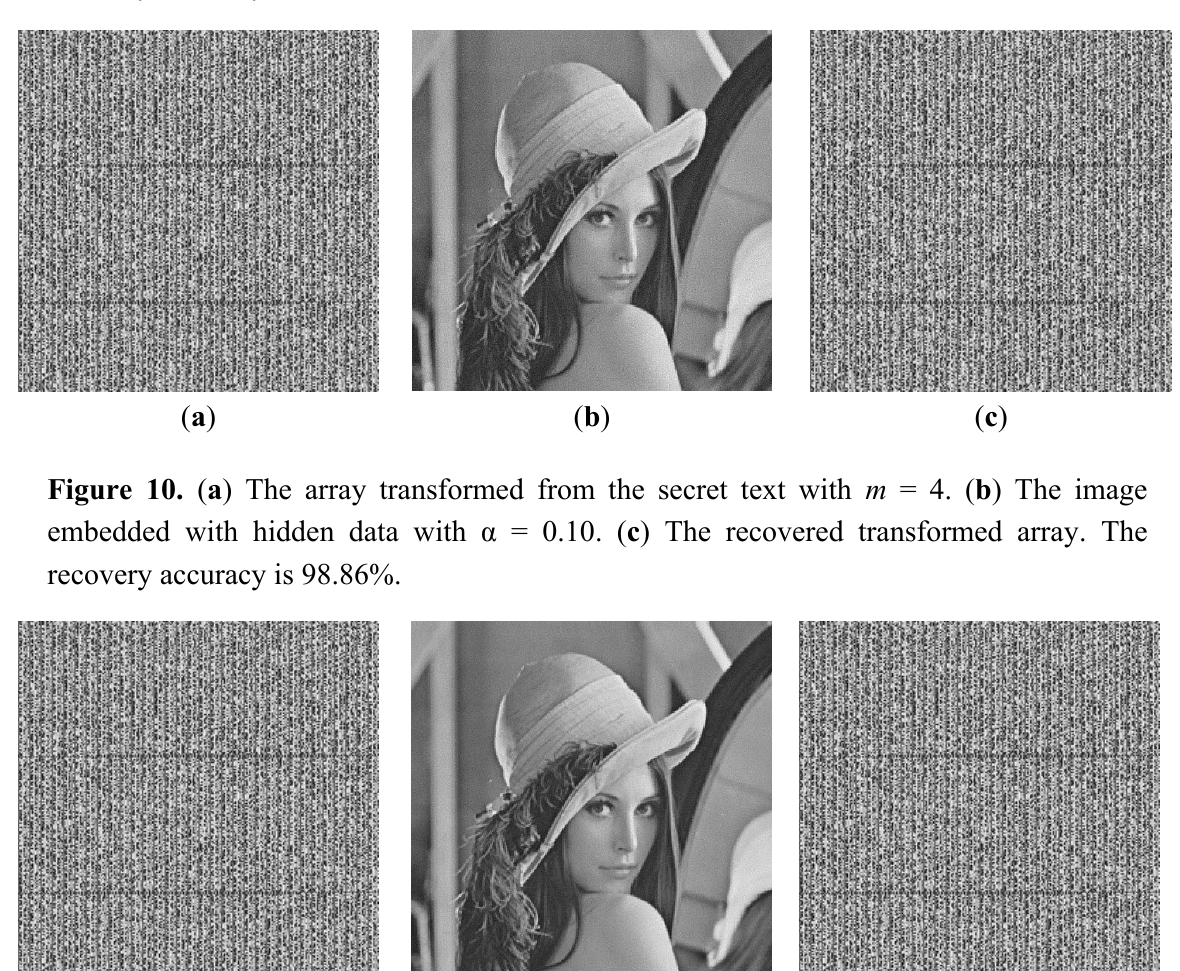
Figure 9. ( a ) The array transformed from the secret text with m = 3. ( b ) The image embedded with hidden data with α = 0.08. ( c ) The recovered transformed array. The recovery accuracy is 100%.